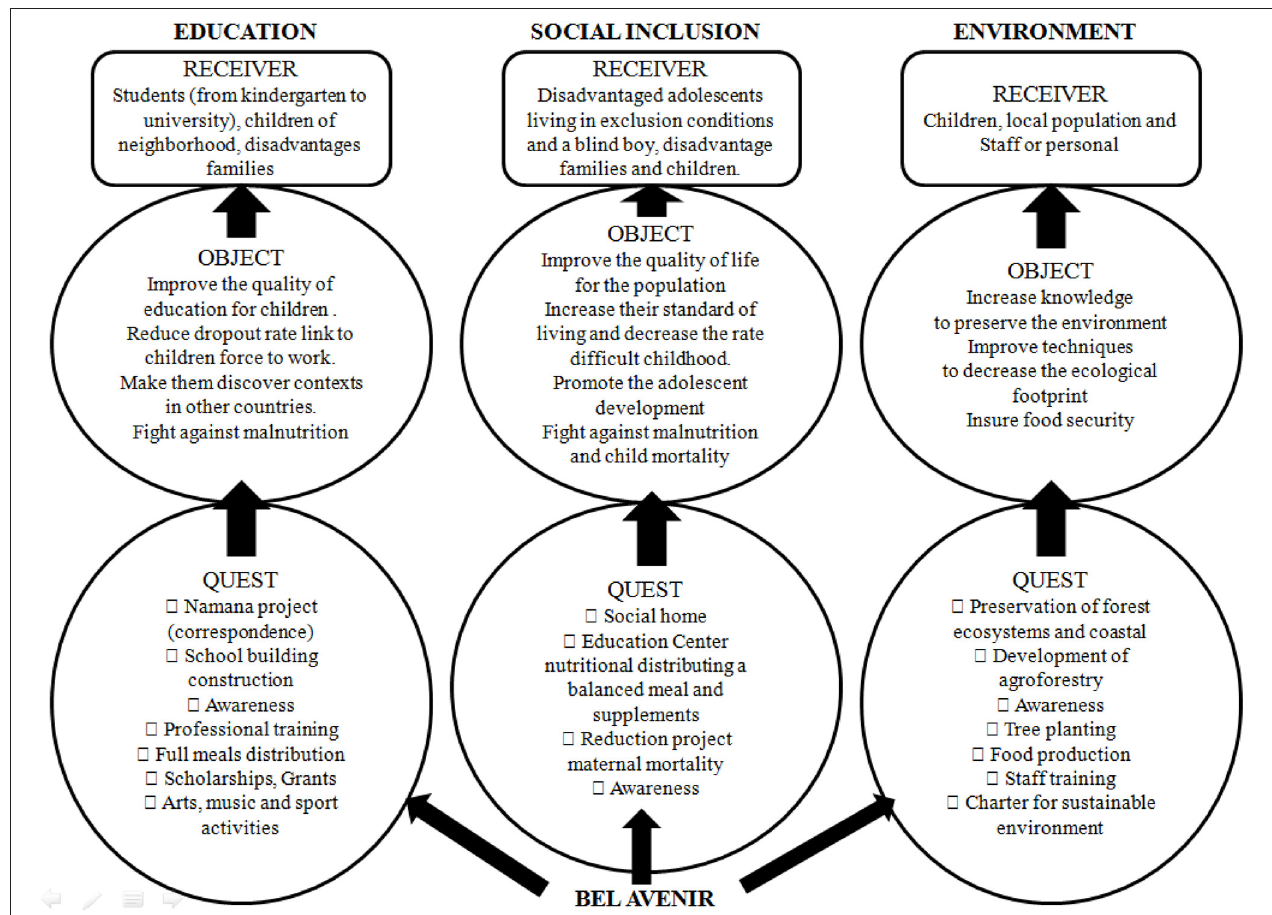
FIGURE 3 | Axis of desire on the three pillars of development in Bel Avenir (Report 2016) 3